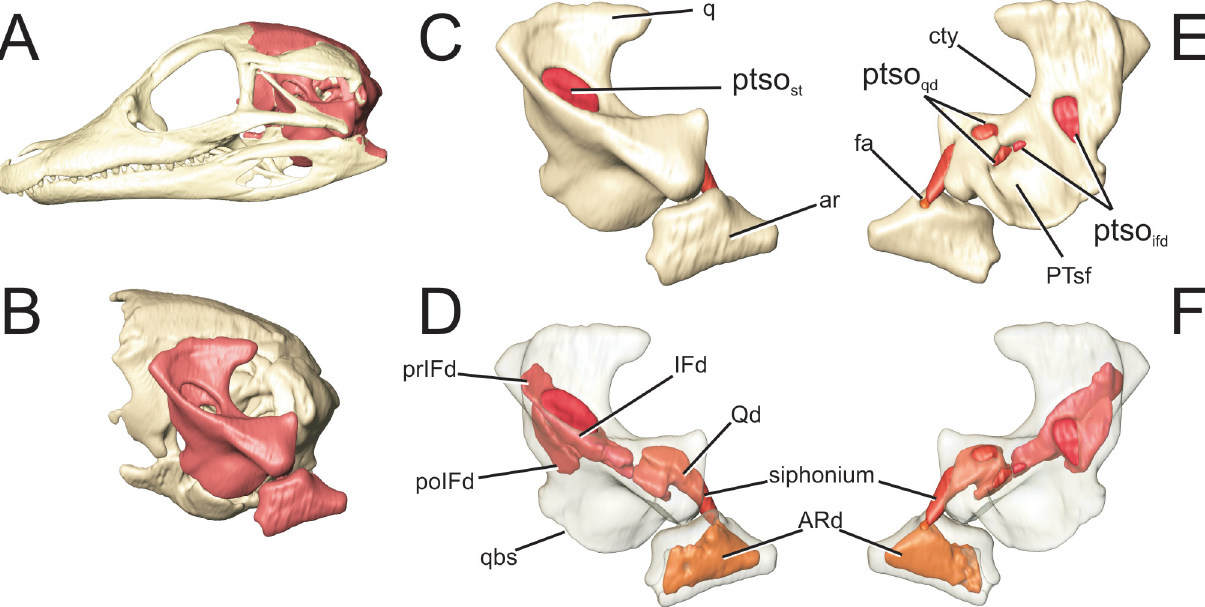
Fig 10. Perinatal Alligator mississippiensis (OUVC 10606) shown in A) left lateral view with the braincase rendered in red and B) with the braincase isolated and the suspensorium rendered in red. Isolated suspensorium in C) left lateral view and D) rendered transparent. Suspensorium in E) medial aspect and F) rendered transparent. ar , articular; ARd , articular diverticulum; cty , crista tympanicum; fa , foramen aerum; IFd , infundibular diverticulum; poIFd , postinfundibular recess; prIFd , preinfundibular recess; ptso ifd , communicating ostium between pharyngotympanic sinus and infundibular diverticulum; ptso qd , communicating ostium between pharyngotympanic sinus and quadrate diverticulum; ptso st , communicating ostium infundibular diverticulum and the subtympanic portion of the pharyngotympanic sinus; qbs , = basisphenoidal suture of quadrate; q , quadrate; Qd , quadrate diverticulum.